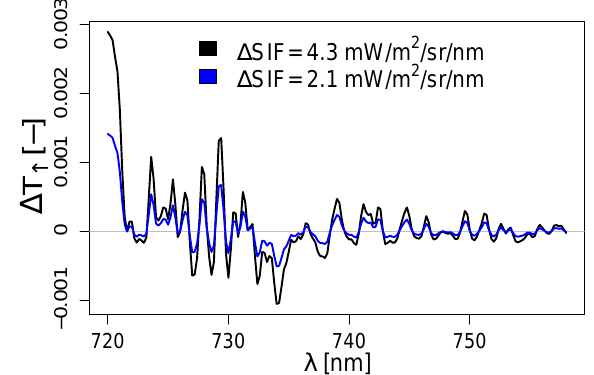
Figure 3. Estimation of the effective atmospheric transmittance in down- and upward direction (black) and in upward direction (red) using Eq. (4) from a sample GOME-2 measurement in the 720– 758nm fitting window.